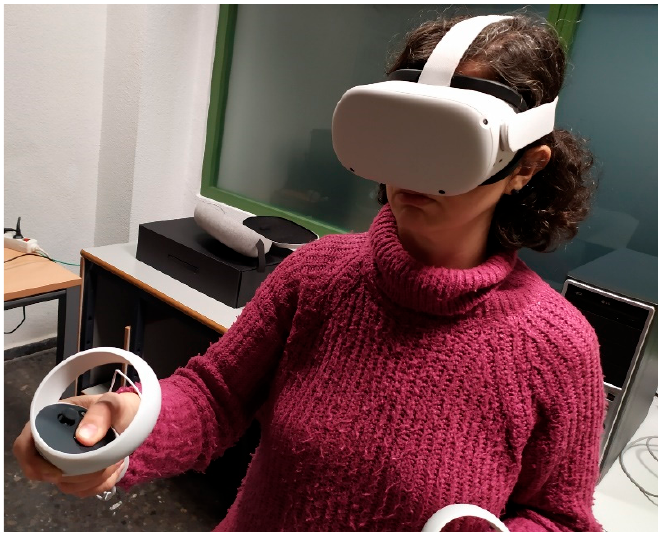
Figure 1. Person using the hardware system: Meta Quest head mounted display and controllers.